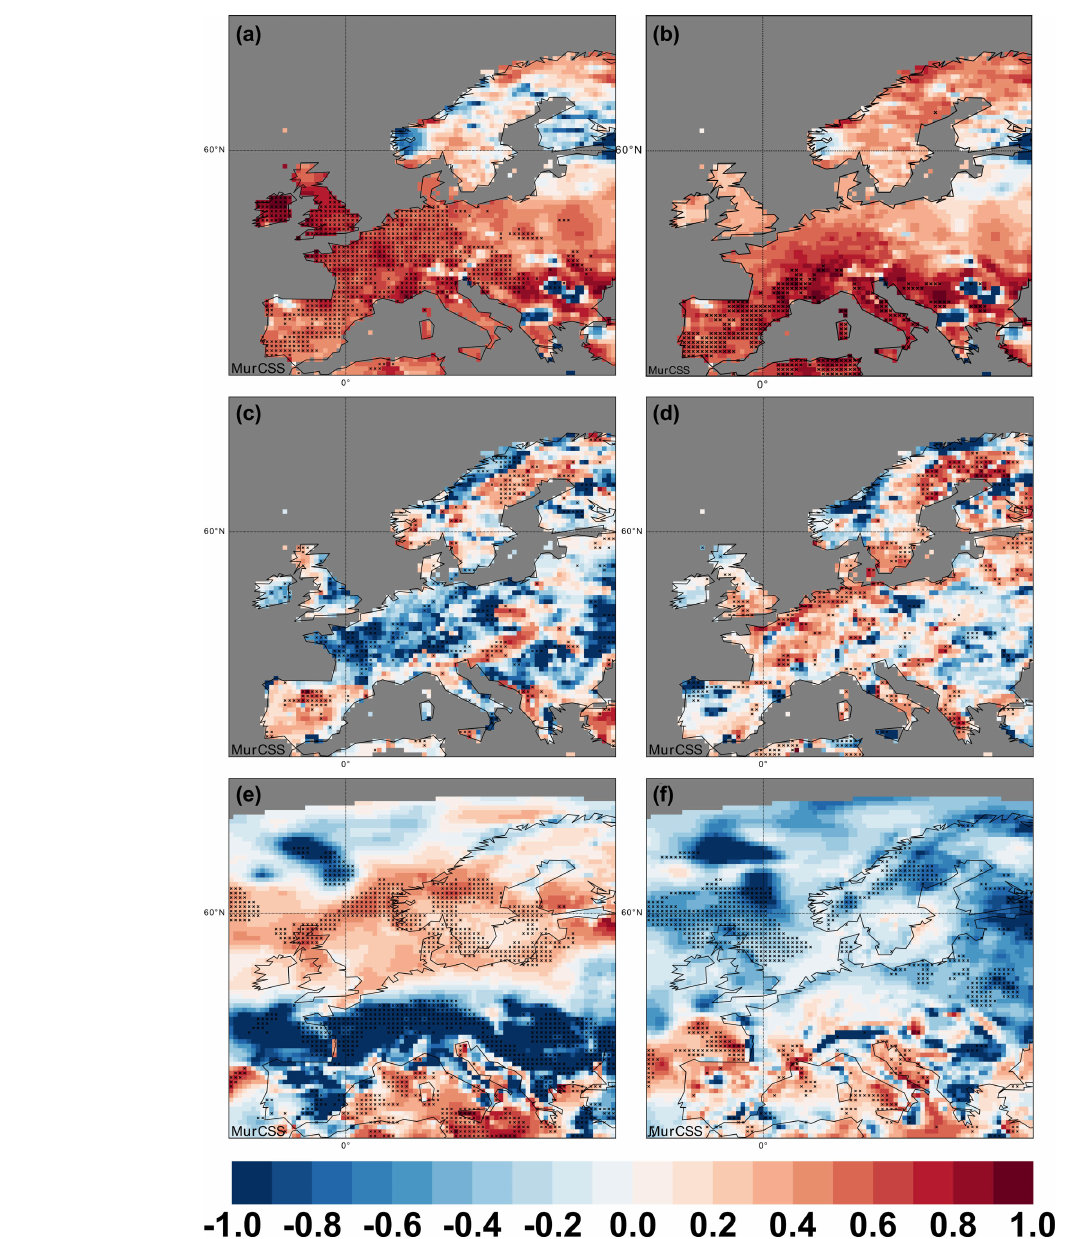
Figure 2. Spatial distribution of the MSESS for the multi-annual mean anomalies of lead years 1–5 for (a) temperature in CCLM_b0, (b) temperature in CCLM_b1, (c) precipitation in CCLM_b0, (d) precipitation in CCLM_b1, (e) wind speed in CCLM_b0, and (f) wind speed in CCLM_b1. As reference dataset we have used the climatology. The black dots indicate significant skill at the 95% level